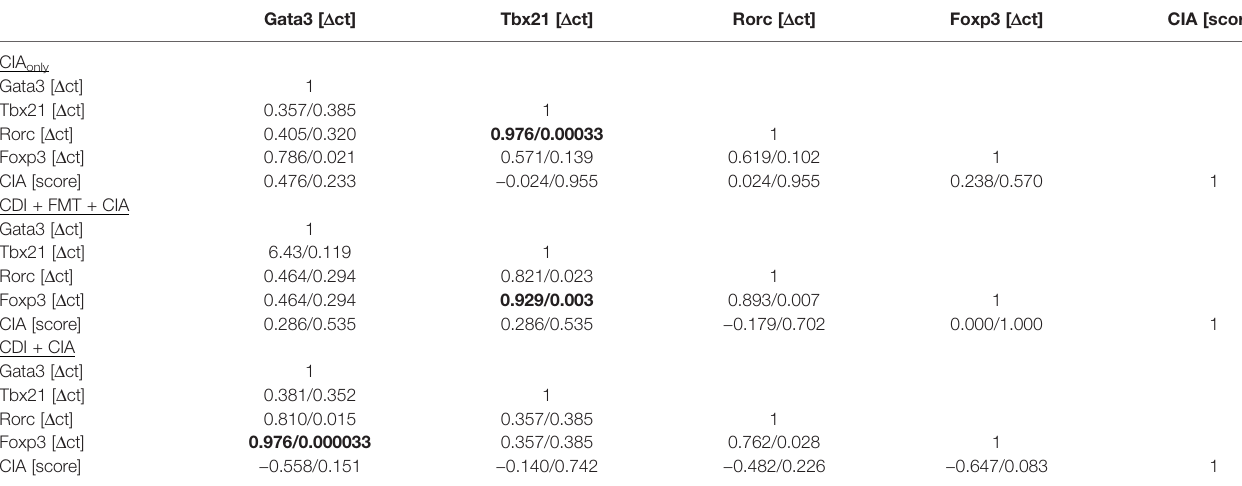
Correlation coef fi cients/p-values resulting from Spearman correlation analyses. According to Bonferroni correction for multiple comparisons, p-values < 0.0033 were considered signi fi cant. Values in bold highlight statistically signi fi cant